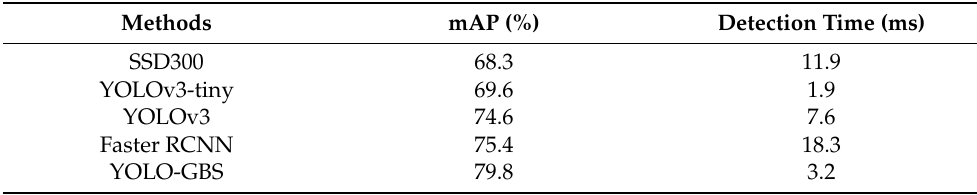
Figure 8. Comparison of detection results. ( a ) Occluded target, dense target. ( b ) Camouflaged target. ( c ) Small target. The image inside the dashed line is a zoom-in of the lower left corner of the original image. Table 2. Comparison of the model